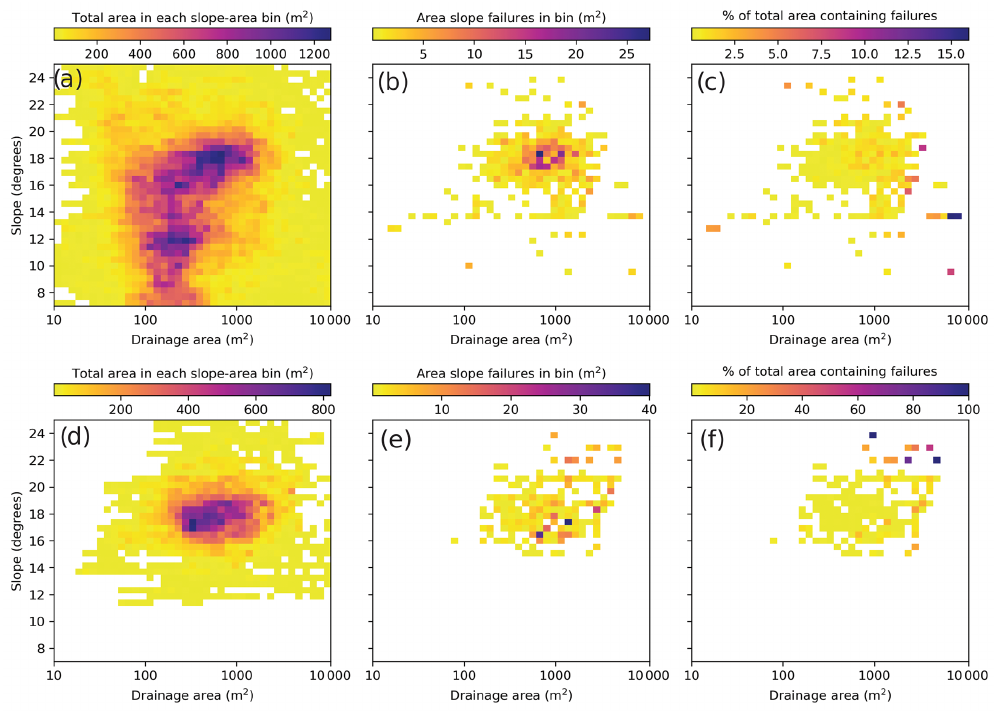
Figure 5. Mapped slope failure locations in slope–area space versus total area covered by UAS surveys in 2018 (a–c) and 2019 (d–f) . (a) Total area of the DEM covered by the 2018 UAS survey that falls into each slope–area bin. (b) The summed areas of failure polygons whose centroids fall within a slope–area bin. (c) The proportion of failure areas to the total area covered by the UAV (the ratio of b to a ). Panels (d–f) are the same but for the 2019 UAV survey footprint. In (f) , note that some failures’ areas were larger than the total area of the slope–area bin in which its centroid fell, resulting in high failure rates for that bin.